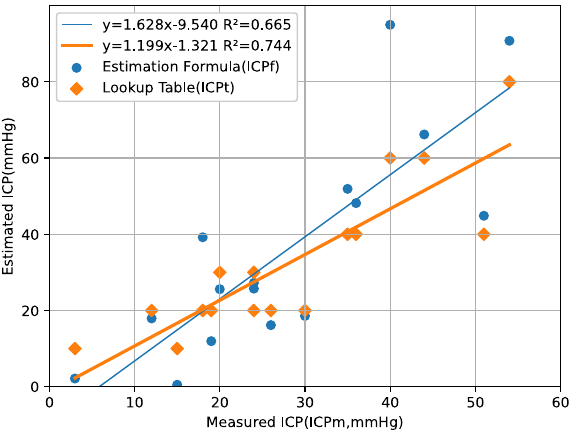
Figure 3. Comparison between intracranial pressures measured intraoperatively (ICPm) and those estimated from preoperative images using the lookup table (ICPt), and the formula (ICPf). Units in mmHg. The correlation between the ICPm and the ICPt (thick trend line) was better than that between the ICPm and the ICPf (thin